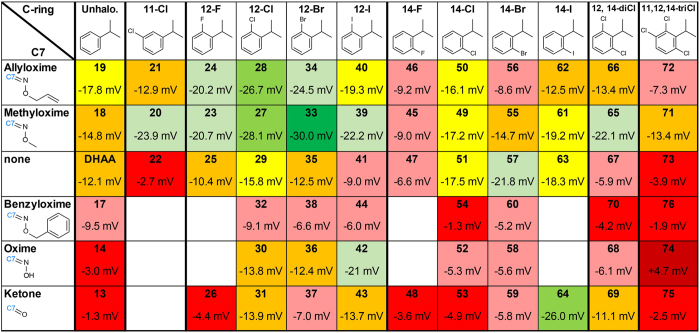
Halogenation-dependent potency.Shift of G(V) (mean values) by the unhalogenated and halogenated DHAA (4) derivates (100 μM), arranged according to halogenation of the C-ring (horizontal) and side chains attached to C7 (vertical). Compounds are color coded according to their potency: dark green: ∆VG(V) ≤ −30.0 mV, green: −30.0 mV < ∆VG(V) ≤ −25.0 mV, light green: −25.0 mV < ∆VG(V) ≤ −20.0 mV, yellow: −20.0 mV < ∆VG(V) ≤ −15.0 mV, orange: −15.0 mV < ∆VG(V) ≤ −10.0 mV, light red: −10.0 mV < ∆VG(V) ≤ −5 mV, red: −5.0 mV < ∆VG(V) ≤ 0.0 mV, dark red: ∆VG(V) > +0.0 mV.